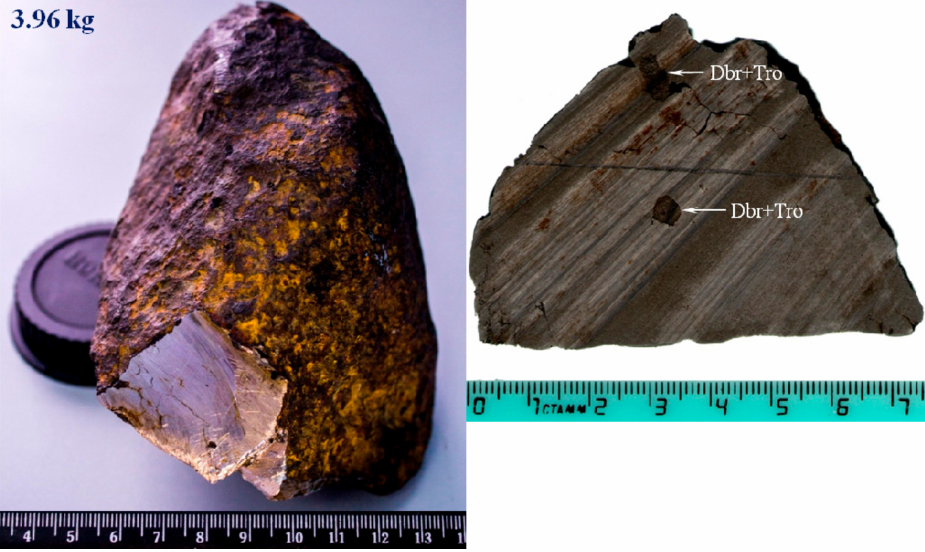
Figure 1. General view of the Uakit iron meteorite (IIAB) and one of cut-o ff s with troilite–daubr é elite nodules. Symbols: Dbr + Tro—troilite–daubr é elite